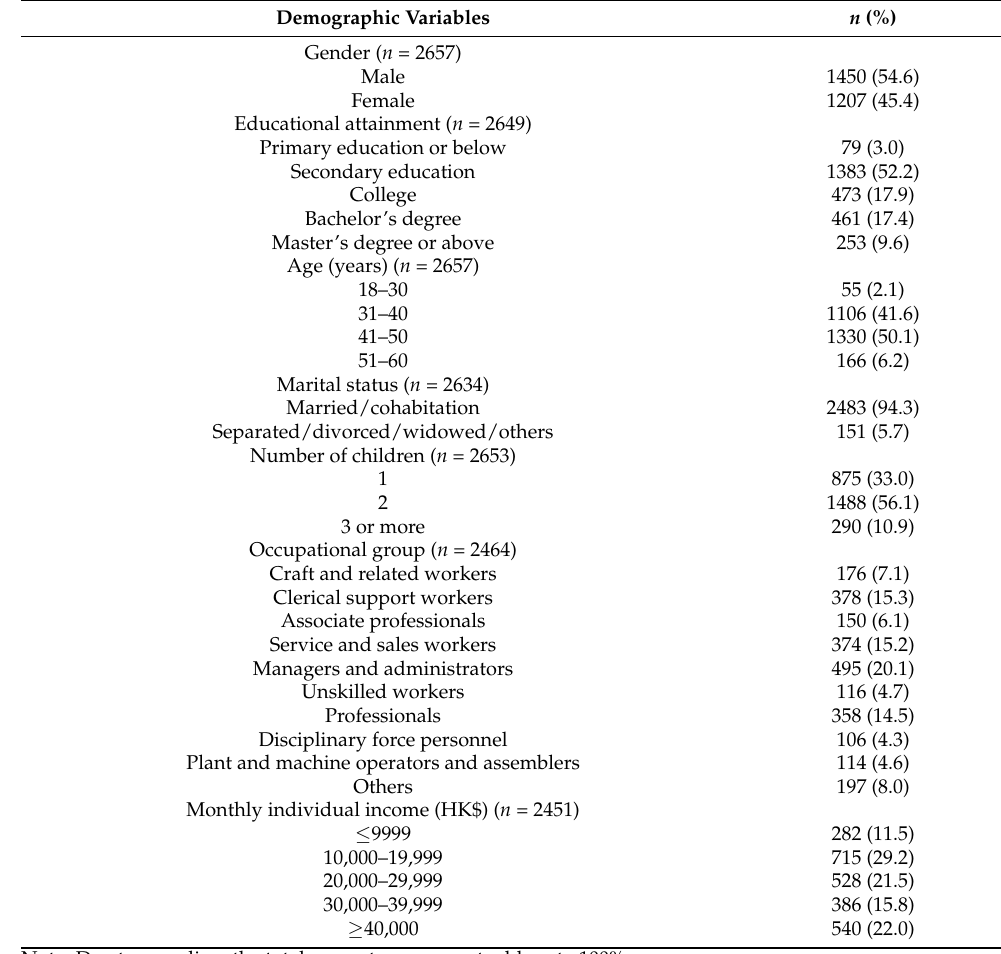
Table 1. Sociodemographic characteristics of the respondents ( n =